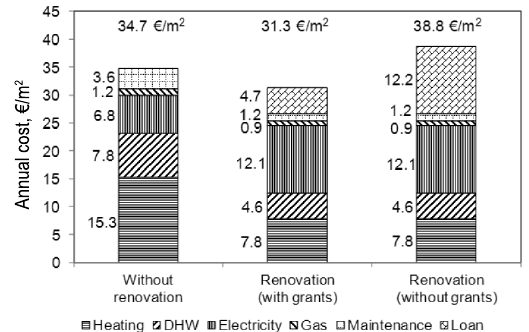
Fig. 8. Annual costs per apartment m 2 without renovation and with